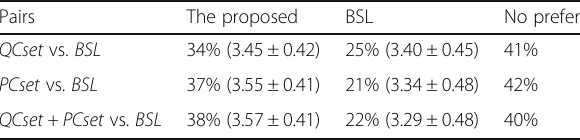
Table 16 Preferences (%) and MOSs (numbers in brackets ± standard deviation) for the two subjective tests Pairs The proposed BSL No